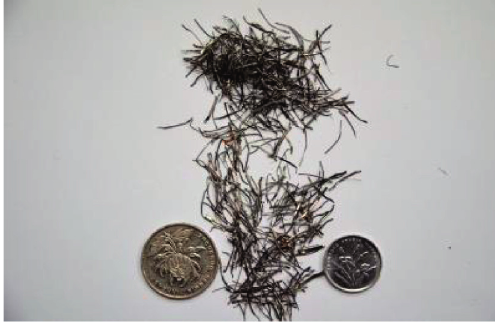
Figure 4: Type II (deformed cut sheet) microsteel fiber.